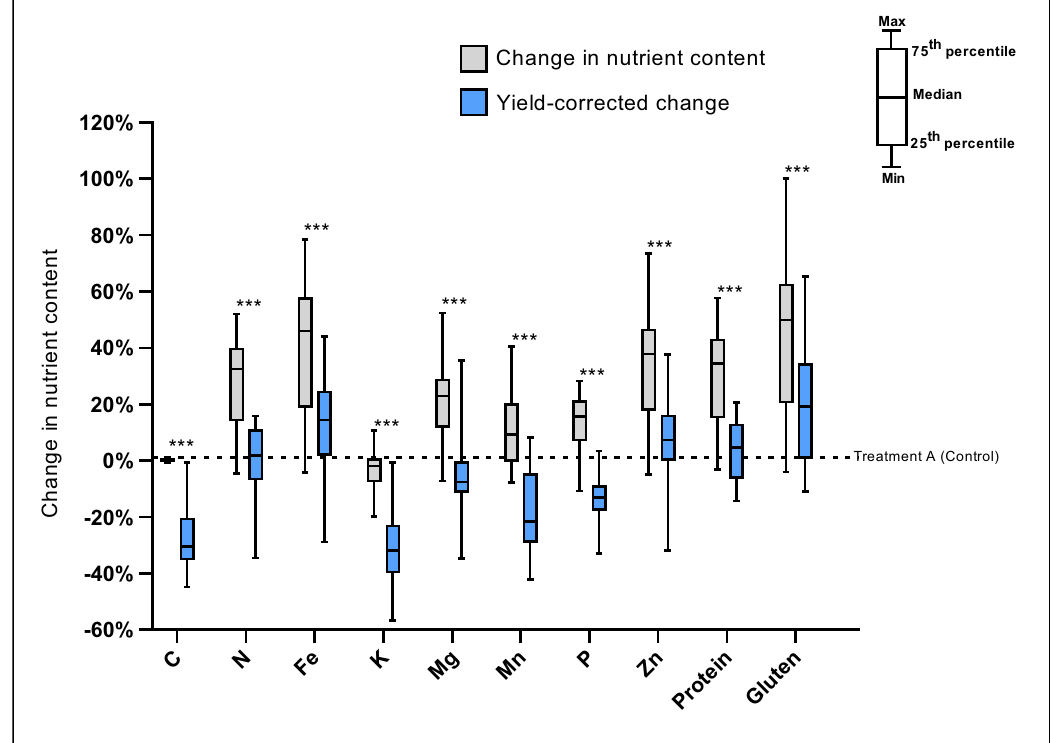
Figure 3. Average percentage change in nutrient content and yield-corrected nutrient content of three European wheat varieties under combined climatic abiotic stress factors, compared to the control. A = Ambient CO 2 , lower temperature settings and no O 3 addition (control). ***Indicates significant difference at p = 0.001 between the normal and the yield-corrected nutrient content, one-tailed pairwise Student’s